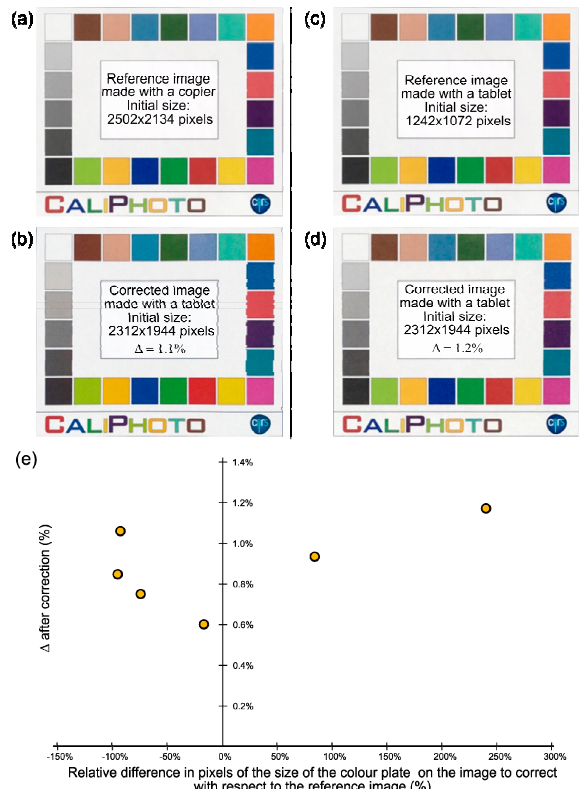
Figure A7. Initial resolution dependency for CaliPhoto image processing. ( a ) Reference image of the colour plate made using a photocopier (Ricoh MP C2504ex) and ( b ) image of the same colour plate made using a tablet camera (iPad), in order to obtain a similar size (in pixels) for the colour plate in the original photograph and in the photocopied image. The value of ∆ , given by Equation (1) (see main text), is equal to 1.1%. When using the tablet to make the reference image of the colour plate ( c ) and the image to correct but with a resolution approximately two times higher, ∆ = 1.2%, as displayed in ( d ). This shows that the correction process depends more on the di ff erence of initial resolution of the colour plate than on the imaging systems used. ( e ) Graph showing ∆ after correction versus the di ff erence of the size of the colour plate in pixels between the image to correct and the reference image in % for a series of images. The best correction is obtained when the size of the colour plate on the image is close to the size of the colour plate on the reference image before